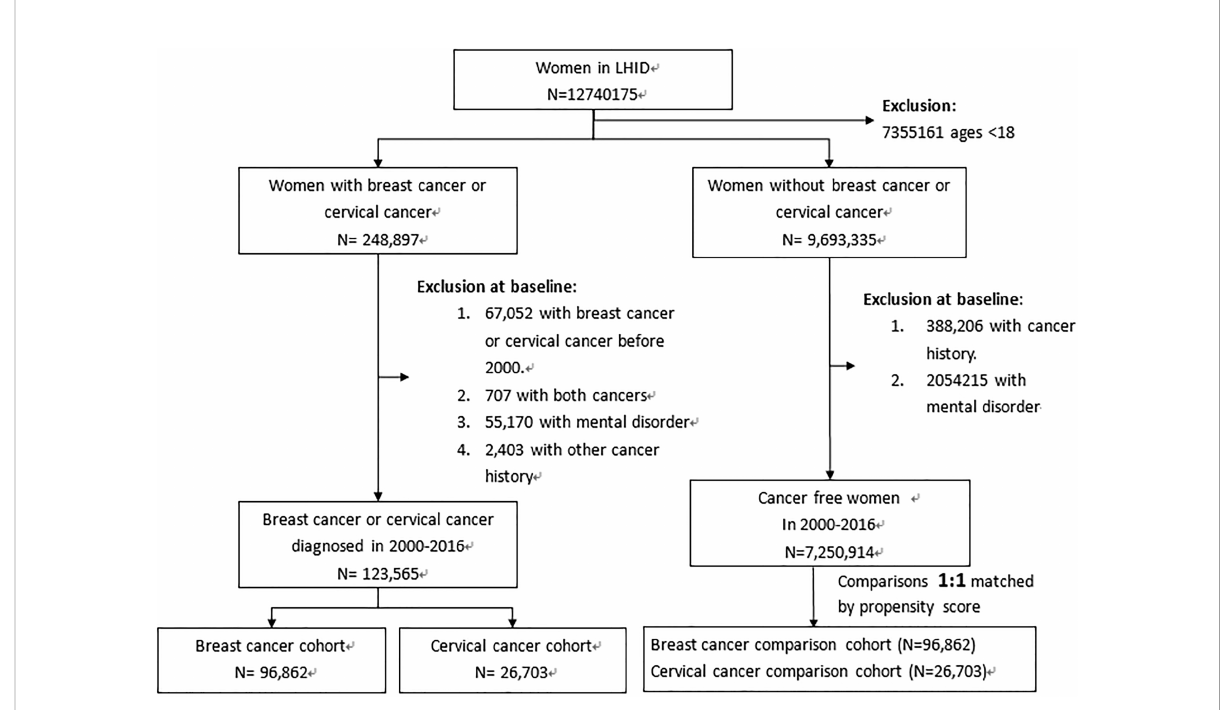
FIGURE 1 Flowchart for establishing study